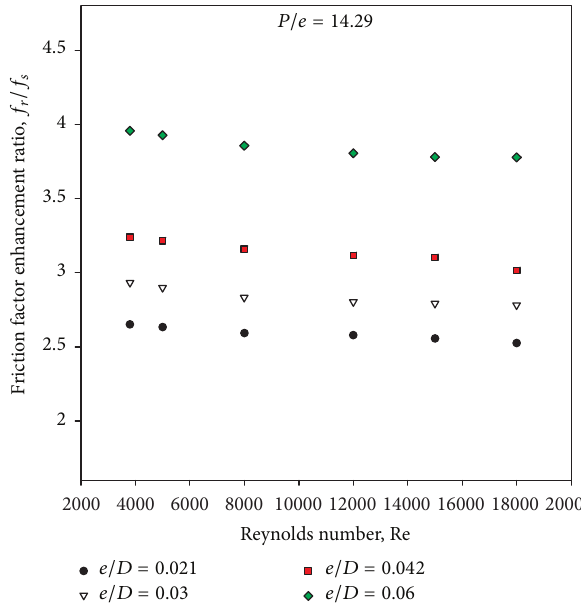
Figure 10: Variation of average friction factor enhancement ratio with Reynolds